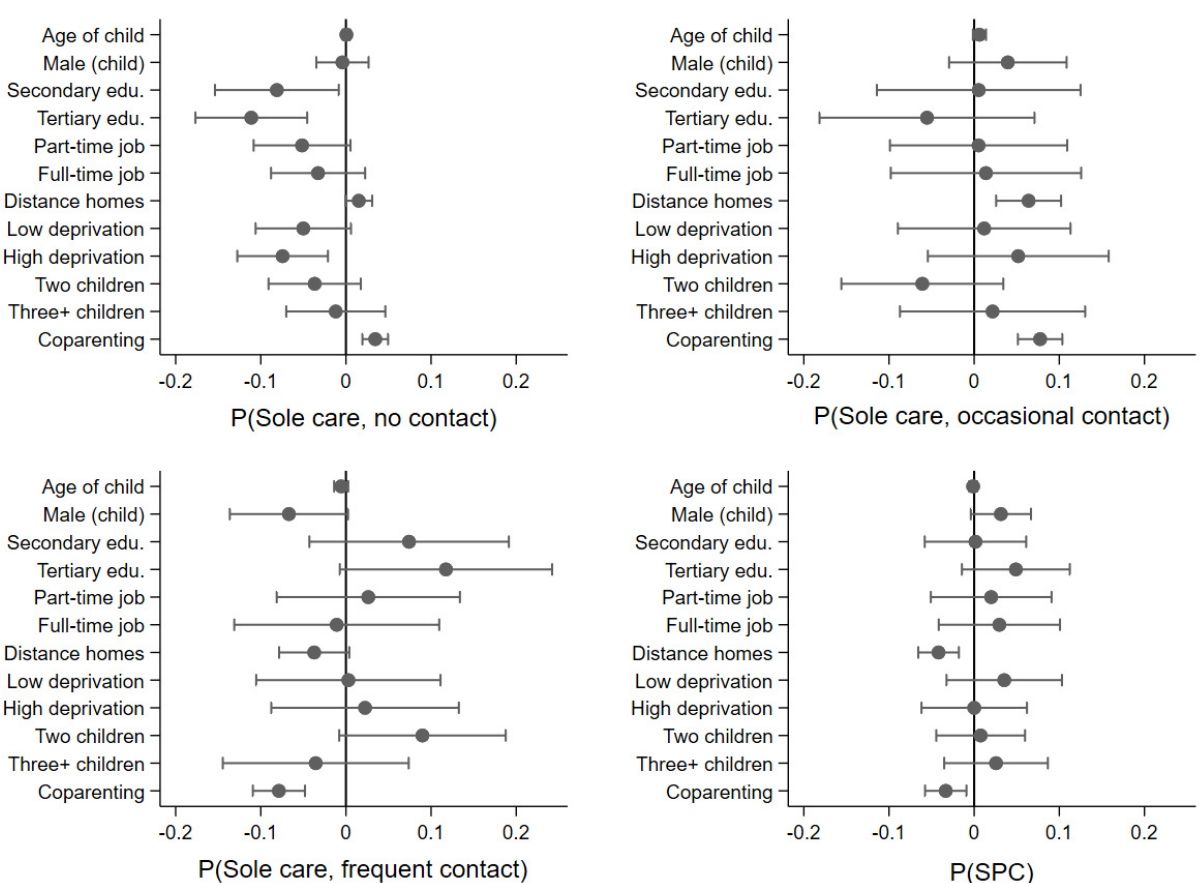
Figure 2. Predicted probabilities of belonging to each post-separation physical custody arrangement based on socio-demographic and socio-economic predictors, as well as the quality of parental coparenting relationship. Reference categories are: Female; Primary levels of education; Not employed; No economic deprivation; One child in the household.